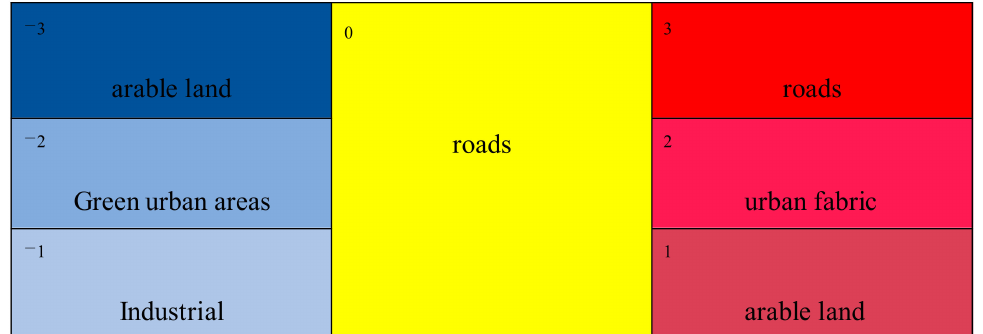
Figure 9. Hot/cold spot overlay with the land-use dataset.